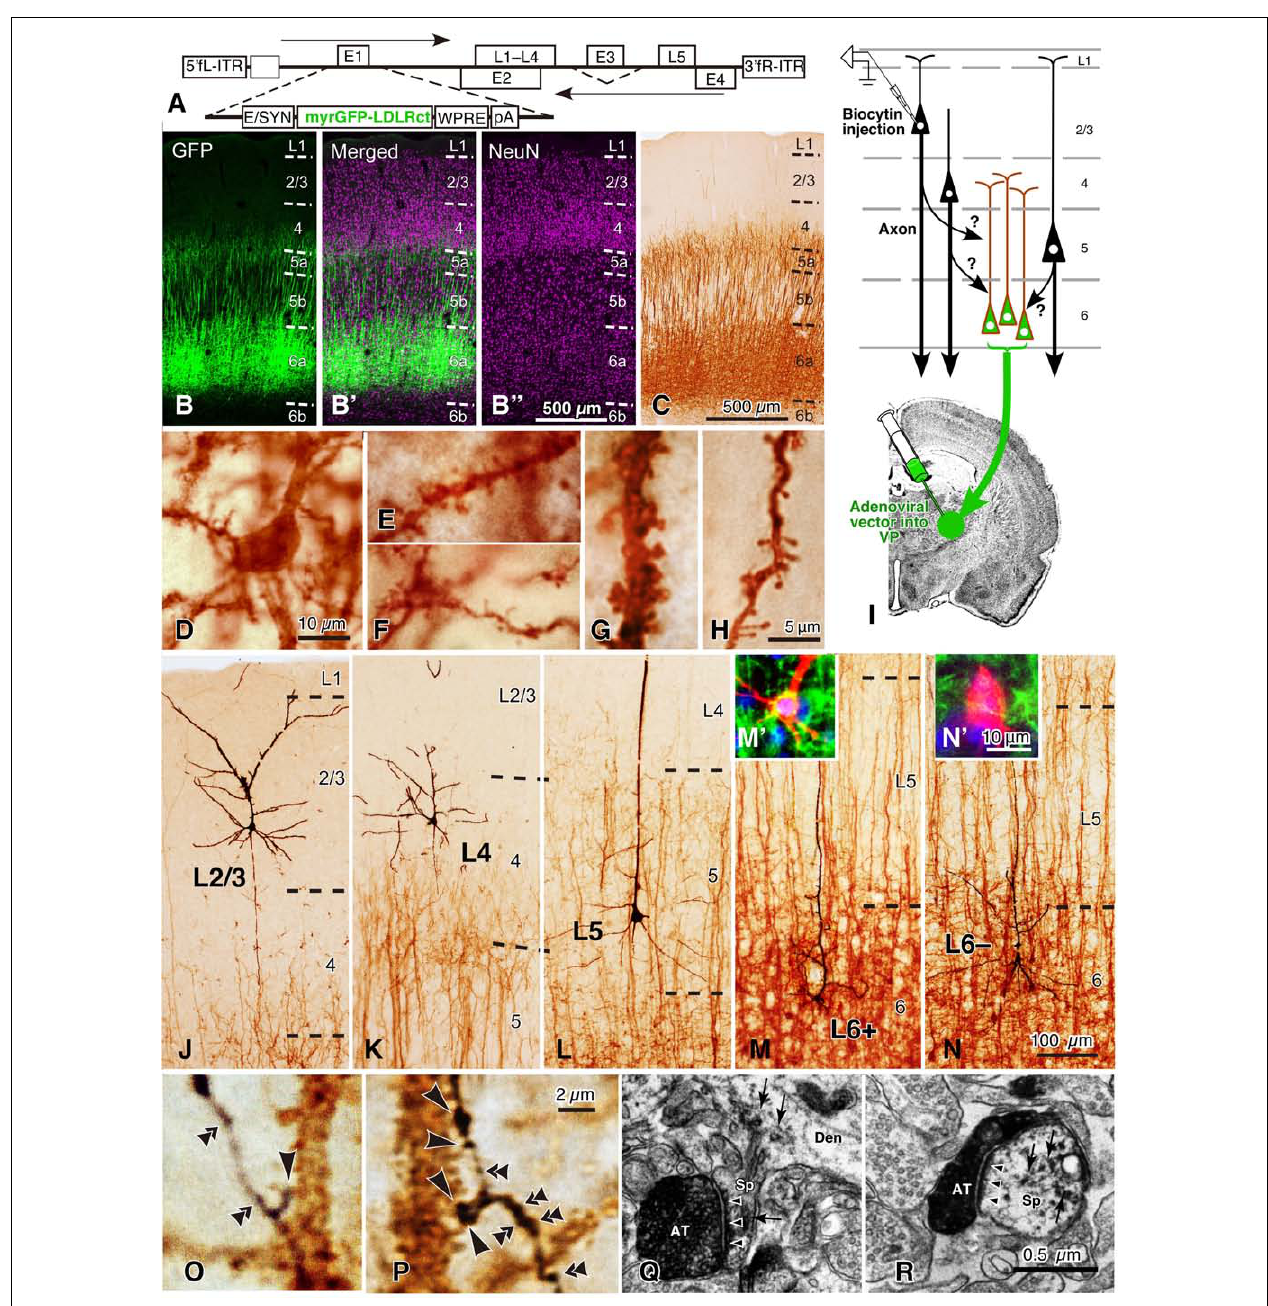
FIGURE 8 | Golgi stain-like labeling of CTNs with a viral vector and intracellular staining of pyramidal neurons in rat areas S1, FL, and HL. When high titers of adenoviral vectors expressing myrGFP-LDLRct ( A ; Kameda etal., 2008) were injected into theVP with 0.6 M NaCl, many L6 pyramidal neurons were retrogradely infected in the somatosensory motor area (B–B (cid:4)(cid:4) ) . After the brown immunoperoxidase staining with anti-GFP antibody and diaminobenzidine (DAB; C ), the cell body (D) , basal dendrites (E,F) , and apical dendrites (G,H) of CTNs were fully visualized. Note that even fine spines were visualized effectively. In 500- μ m-thick cortical slices, single spiny neurons were labeled intracellularly (I) and visualized black (J–N) by the peroxidase method with DAB and nickel. In L6, retrogradely labeled (M (cid:4) ) and unlabeled neurons (N (cid:4) ) were indicated by L6 + and L6 − pyramidal neurons, respectively. Most L6 − neurons were considered to belong to corticocortical